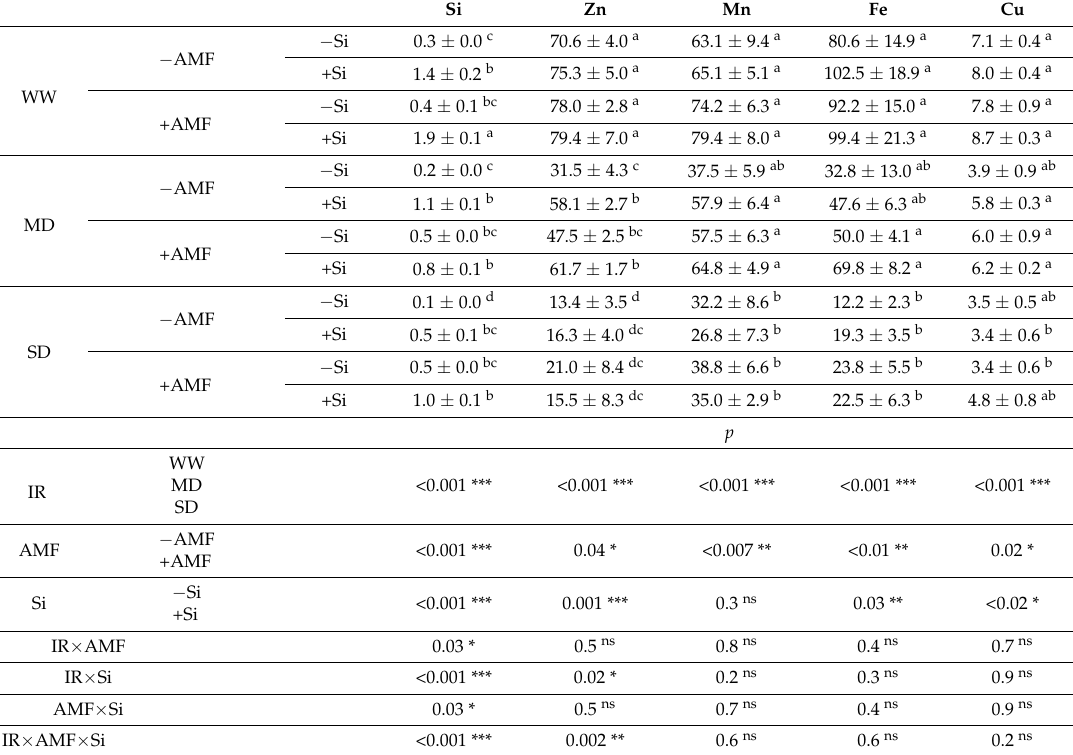
Table 4. The concentrations of Si (%), Zn ( µ g g − 1 DW), Mn ( µ g g − 1 DW), Fe ( µ g g − 1 DW), and Cu ( µ g g − 1 DW) in the leaf of strawberry plants at harvest after six experimental weeks under three irrigation regimes (IR): well-watered (WW), mild drought (MD), and severe drought (SD) without ( − AMF) or with inoculation with arbuscular mycorrhizal fungus (+AMF) Rhizophagus clarus (Walker & Schüßler), in the absence ( − Si) or presence of silicon (+Si, 3 mmol L − 1 Na 2 SiO 3 ). The numbers show the treatment means (4 replicates) ± SE of the mean. Means with the same letters are not significantly different. Interactions among the main factors are indicated as *** p < 0.001, ** p < 0.01, and * p < 0.05 and ns as not significant (Tukey test, alpha = 0.05).